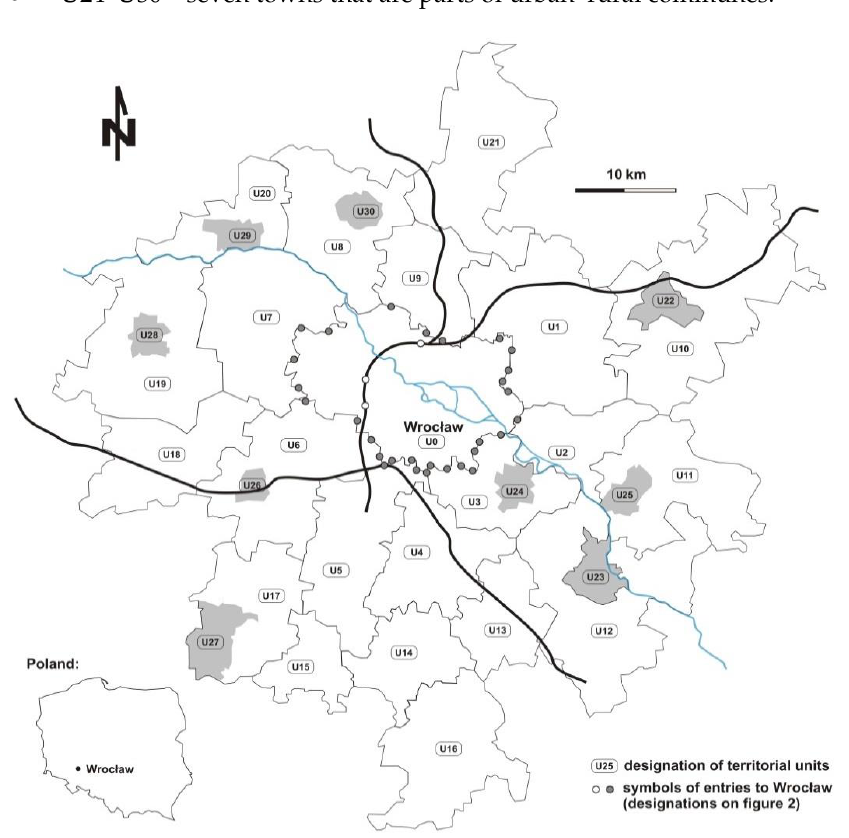
Figure 1. The study area: the Wrocław agglomeration (source: own research). Basic data for the aforementioned units are given in Table 1. In Figure 1 black lines mark “limited access roads” (motorways and expressways). Urban communes or towns that are parts of urban–rural communes are distinguished in grey. The Odra River is also marked, because outside Wrocław there are only three bridges on the Odra in the analyzed area, so the river is a barrier to traffic. The boundaries of the communes are shown with black